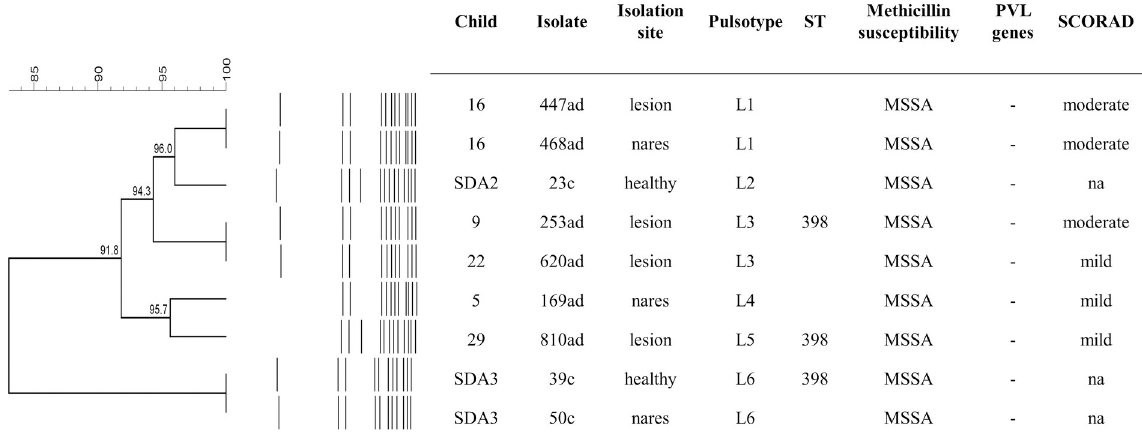
Fig 4. Dendrogram of the clonal profiles obtained after digestion with the restriction enzymes Apa I and SmaI , and general characteristics of nine S . aureus isolates from nasal and skin colonization of children with and without AD. MSSA- Methicillin-sensitive Staphylococcus aureus ; na- Not applicable; PVL- Panton-Valentine leukocidin; SDA- Child without atopic dermatitis; ST- Sequence-type.